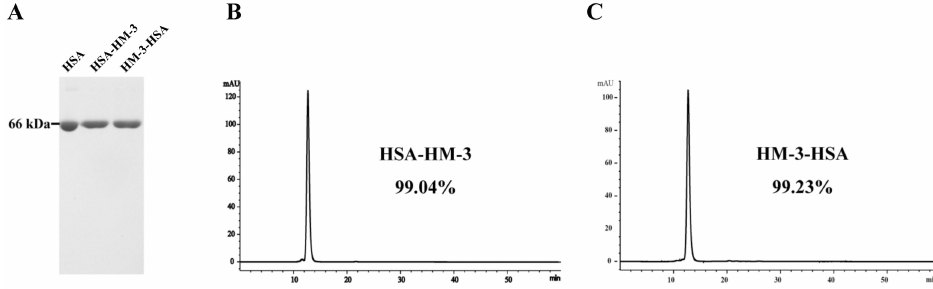
Figure 2. The purification and identification of HM-3/HSA. ( A ) Non-reducing SDS-PAGE analysis of purified HM-3/HSA. ( B , C ) Purified HM-3/HSA was analyzed in HPLC. Column: Protein-Pak TM 125A, 7.8 × 300 mm column; PN: WAT084601. The mobile phase involved: 50 mM PB, 1.0 M NaCl